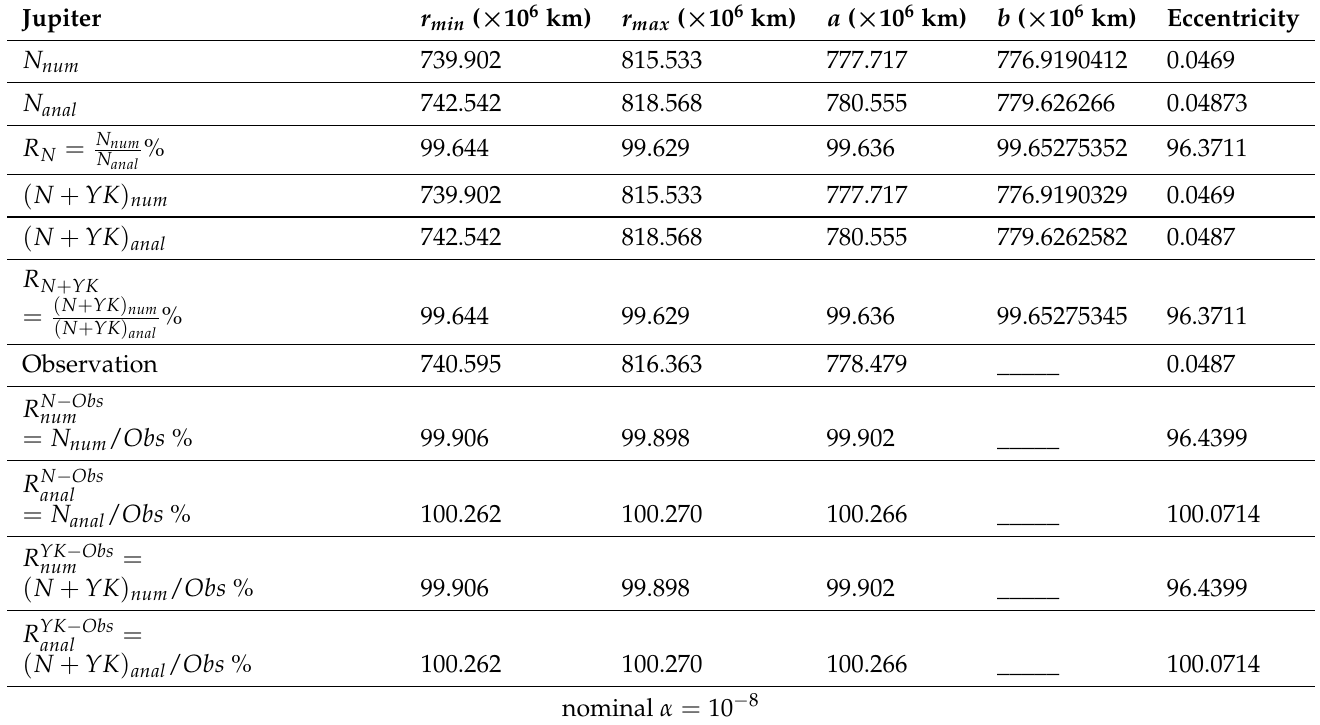
Table A9. The values of the calculated and observational astronomical parameters, for nominal α , of the planet Jupiter, whose number of moons is